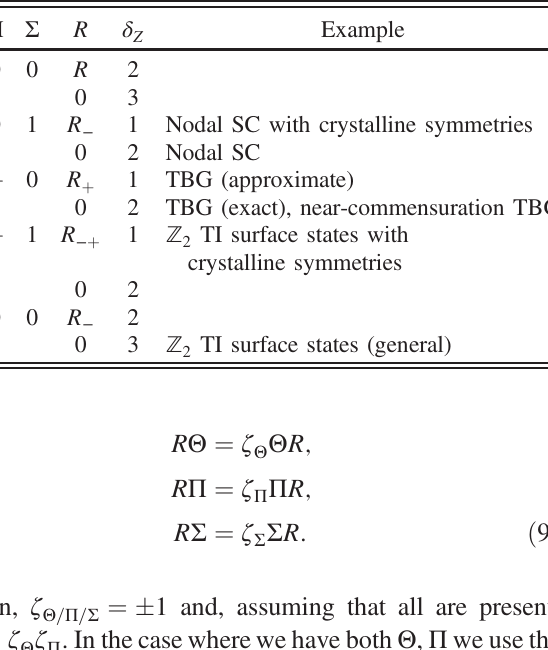
TABLE I. δ for the symmetry groups (with Θ , Π , Σ , and/or R Z symmetries) which preserve a single Dirac cone. Zero indicates the absence of a symmetry, while (cid:3) denote the square of the symmetry. The signs at the subscripts of R indicate whether R commutes or anticommutes with the other symmetries. The calculation of δ here assumes the presence of a C 3 or C 4 Z symmetry. See Table II for an elaborated calculation of δ Ref. [9] for a discussion of the example in row 3, Sec. III A for